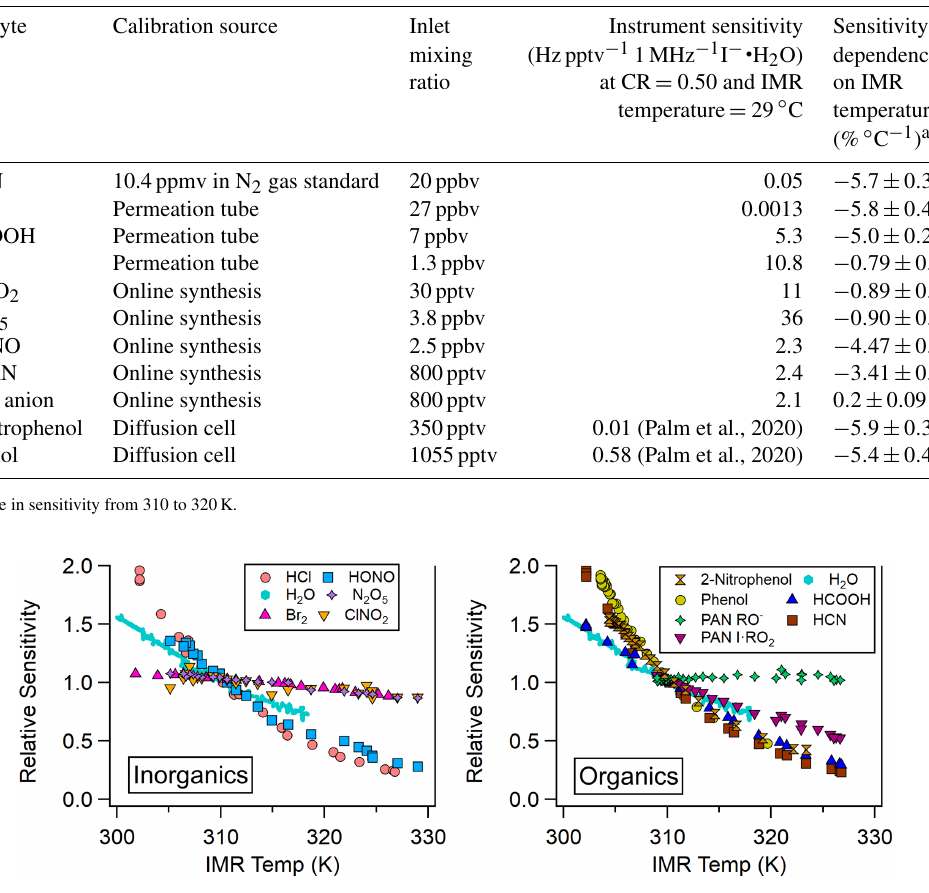
Figure 3. Relative sensitivity (normalized to sensitivity at 310K) as a function of IMR temperature for organic and inorganic atmospheric trace gases detected via iodide-adduct chemical ionization.